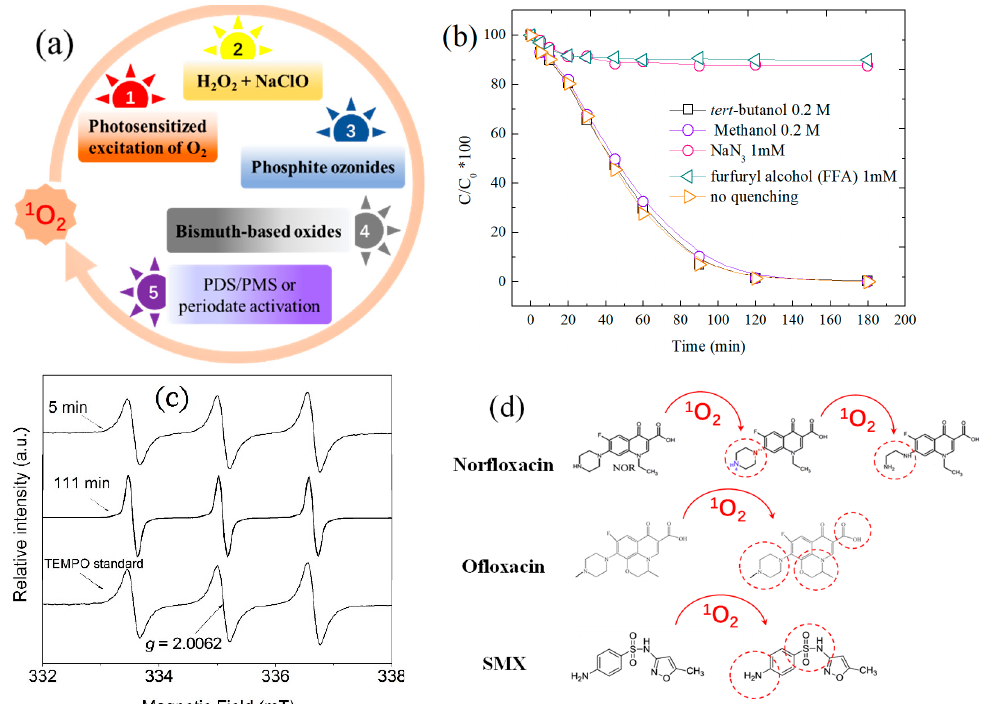
Figure 1. ( a ) Reported pathways of 1 O 2 evolution; ( b ) the quenching effect of 1 O 2 on phenol degradation with β -MnO 2 (data reorganized from [19]); ( c ) EPR characteristic spectrum of TEMP- 1 O 2 (figure reprinted from [31]). The EPR spectrometer settings were as follows: modulation frequency, 100 kHz; modulation width, 0.079 mT; scanning field, 335 ± 10 mT; amplitude: 2–500; time constant, 0.1–0.3 s; sweep time, 4 min; microwave power, 4 mW; and microwave frequency, 9.41 GHz.; ( d ) oxidation pathways of some emerging contaminants by 1 O 2 [8,34,38], reprinted with permission from Elsevier.